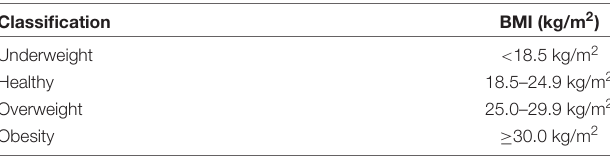
TABLE 1 | Classification of underweight, healthy, overweight, and obesity categories using BMI.